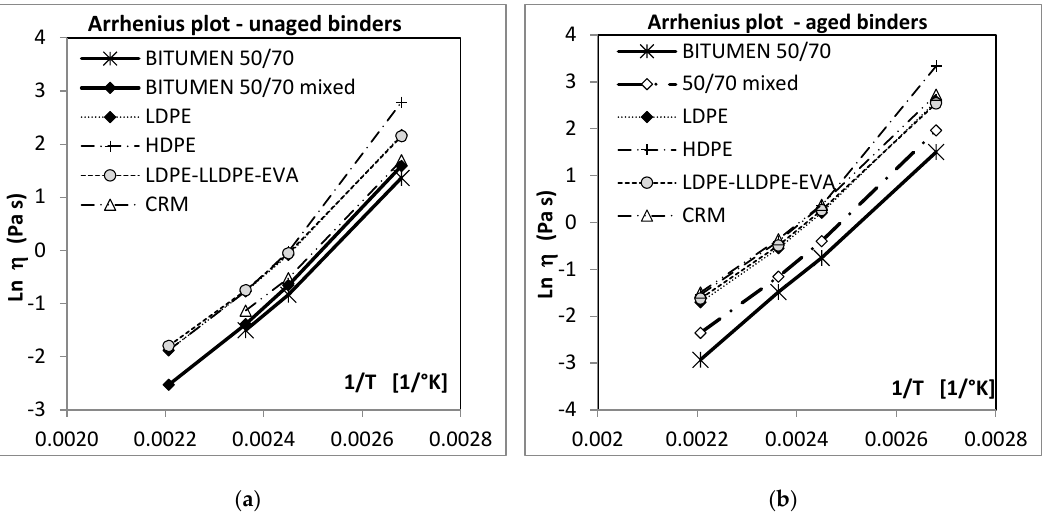
Figure 2. Logarithm of dynamic viscosity against the reciprocal of absolute temperature (Arrhenius plot) for the binder studied: ( a ) before aging; ( b ) after aging at the